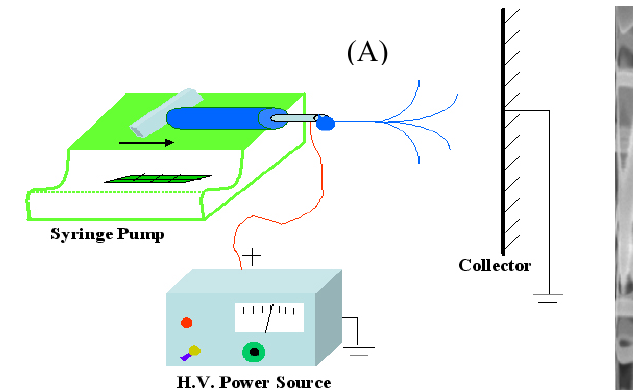
Figure 1. (A) A schematic of electrospinning process. (B) A SEM image of typical electrospun